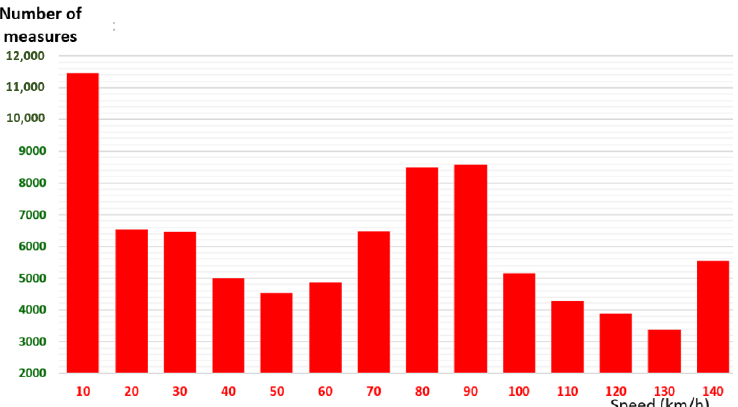
Figure 5. Distribution of data according to speed.